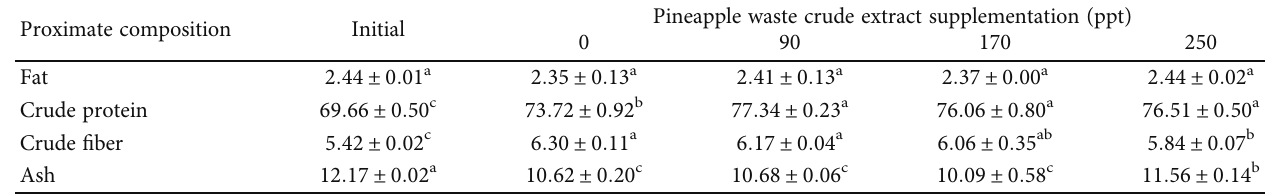
Table 4: Proximate composition (%) of Paci fi c white shrimp whole body without hepatopancreas (dry weight) fed with pineapple waste crude extract supplementation diet at di ff erent levels for 80